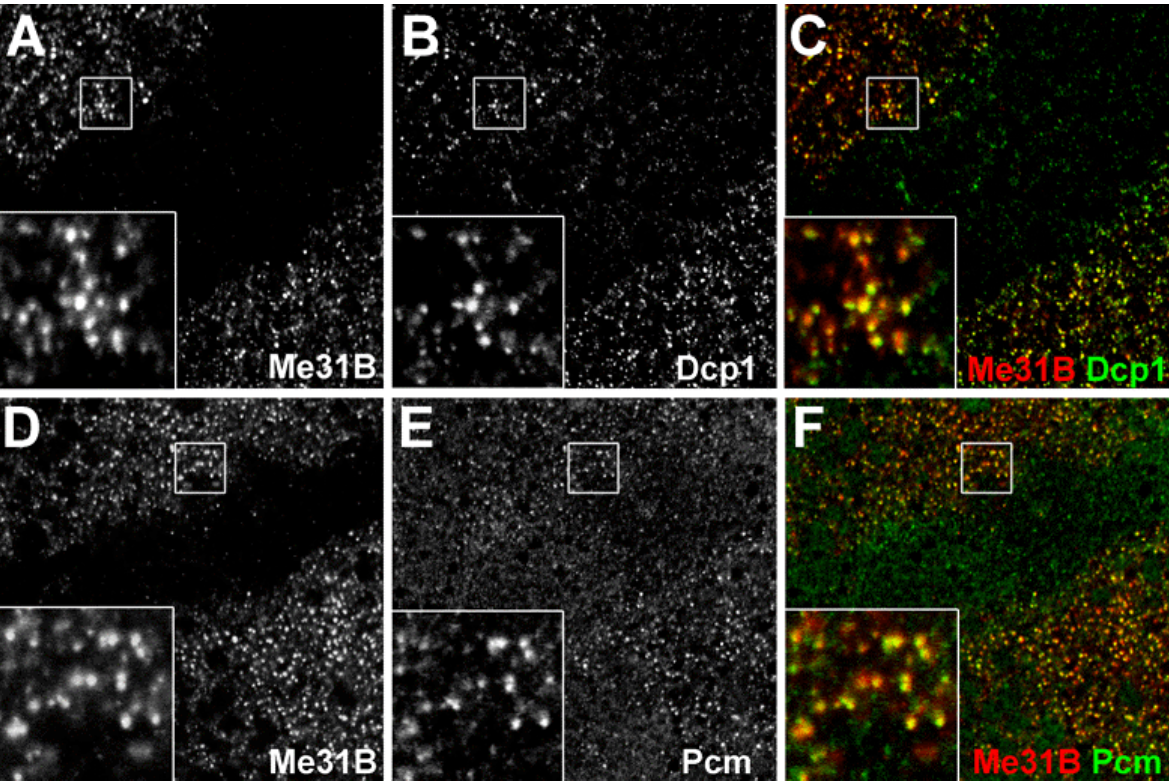
FIGURE 2 . Depletion of Me31B reduces Dcp1 and Pacman (Pcm) expression. High-resolution images of wing imaginal discs, showing the colocalization of Me31B in cytoplasmic foci with the P-body components Dcp1(B and C) and Pcm (E and F), the Drosophila homologue of the exoribonuclease Xrn1. Depleting Me31B by RNAi[12] induces the loss of P-bodies in the wing imaginal disc; less bright Dcp1 and Pcm expressing foci can be observed in areas where Me31B is depleted (marked by the absence of Me31B in A). Expression of a Me31B hairpin construct[12] was driven with patched -Gal4 (Bloomington), reducing Me31B expression at the anterior/posterior boundary of the wing imaginal disc. Wing discs of 3rd instar larvae were dissected, fixed with 4% formaldehyde, and double stained with α -Me31B[43] and α -Dcp1[12] or α